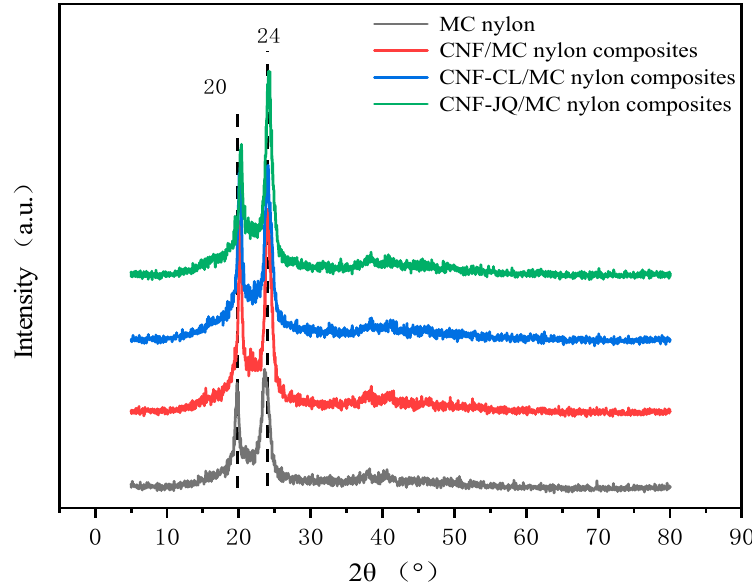
Figure 5. WAXD diffraction pattern of MC nylon and its composites.